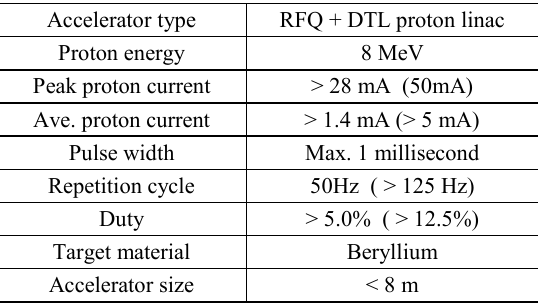
Fig. 1. An RFQ and a DLT-type linac-based neutron source for BNCT at the University of Tsukuba, Japan. Table 1. Main specifications for the demonstrator of